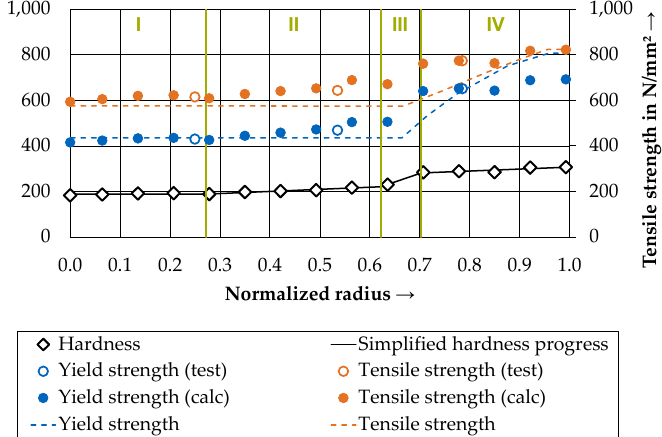
Figure 8. Hardness [1], tensile and yield strength distribution over the normalized radius including values from the literature (dashed lines) [6] and separated into the aforementioned zones by vertical green lines (Table 6).